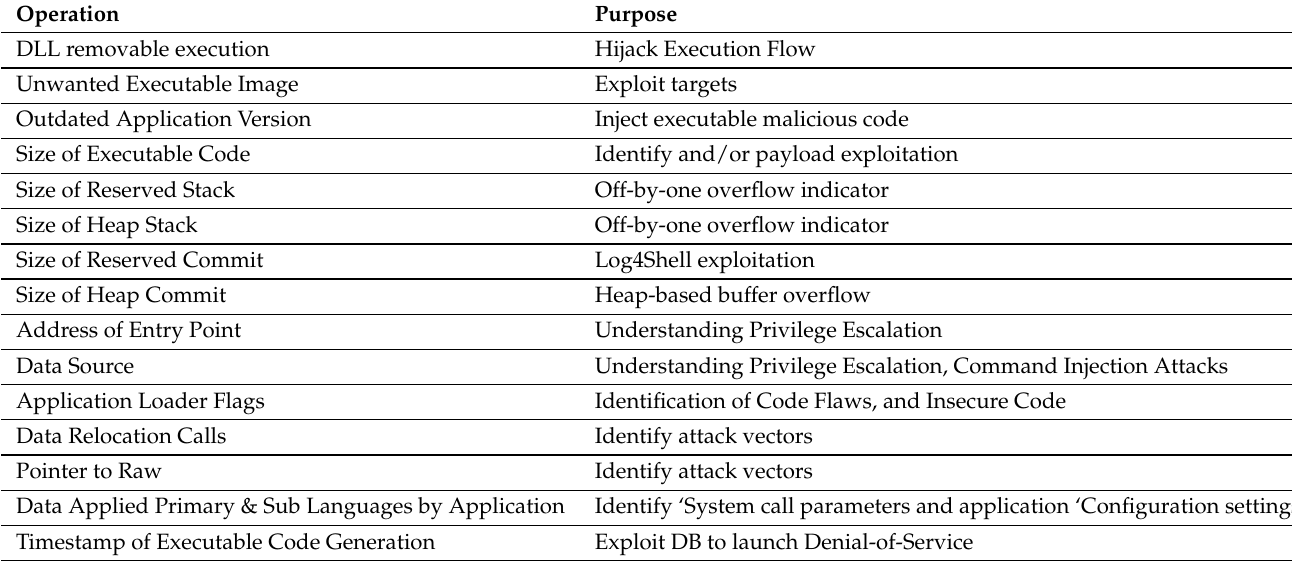
Table 4. Observed attributes for malicious software and/or process